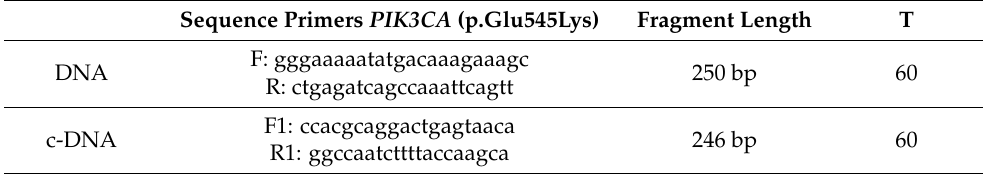
Table 2. Sequence primers PIK3CA